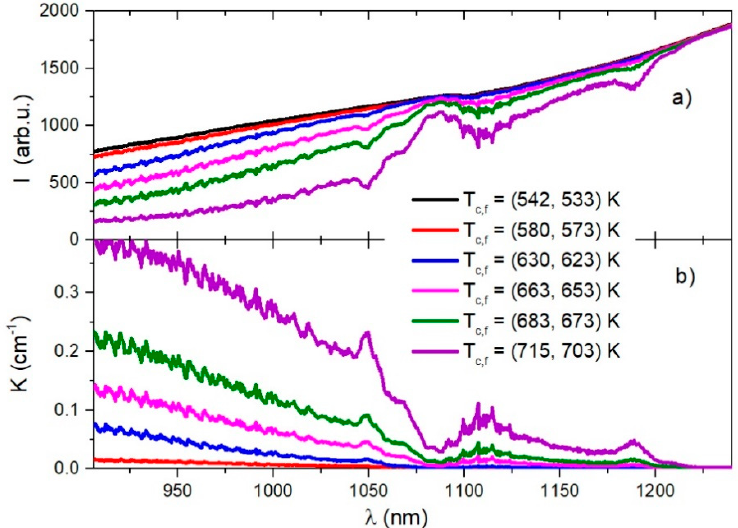
Figure 2. Relative intensity (in arbitrary units) of the light transmitted through a sapphire absorption cell at several temperatures T c , f is shown in ( a ). The alkali mixture absorption coe ffi cients for the corresponding temperatures are shown in ( b ).